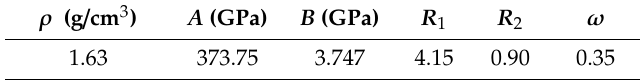
Table 3. The JWL model used to define the TNT material model in Ansys / Autodyn. ρ (g / cm 3